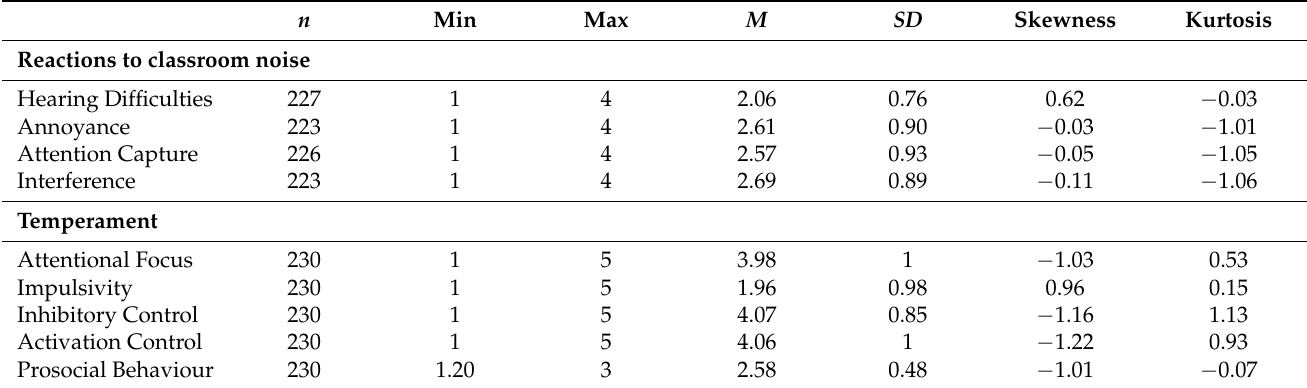
Table 3. Descriptive statistics for all the variables used in Study